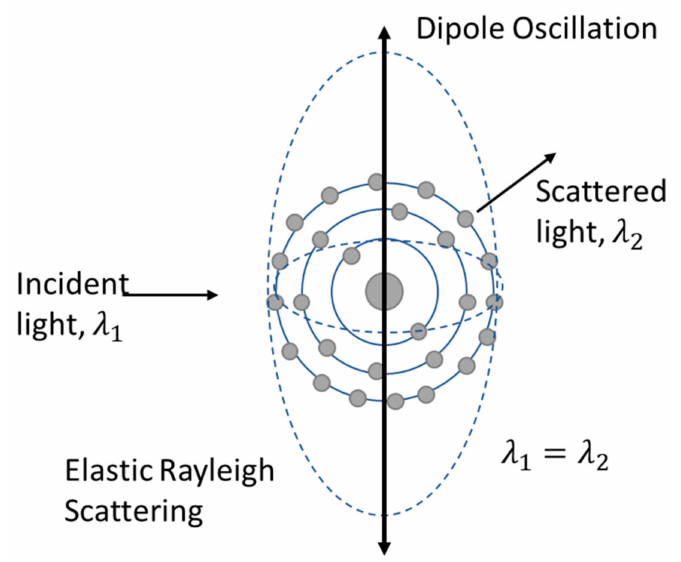
Figure 11. Induced dipole in presence of applied harmonic field. Adapted from